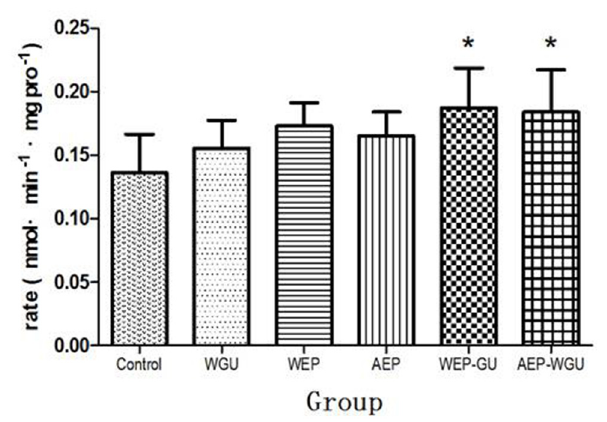
FIGURE 3 |Activities of CYP 2C9 in liver microsomes ( ¯ x ± s, n = 6). ∗ P < 0.05 compared with control.